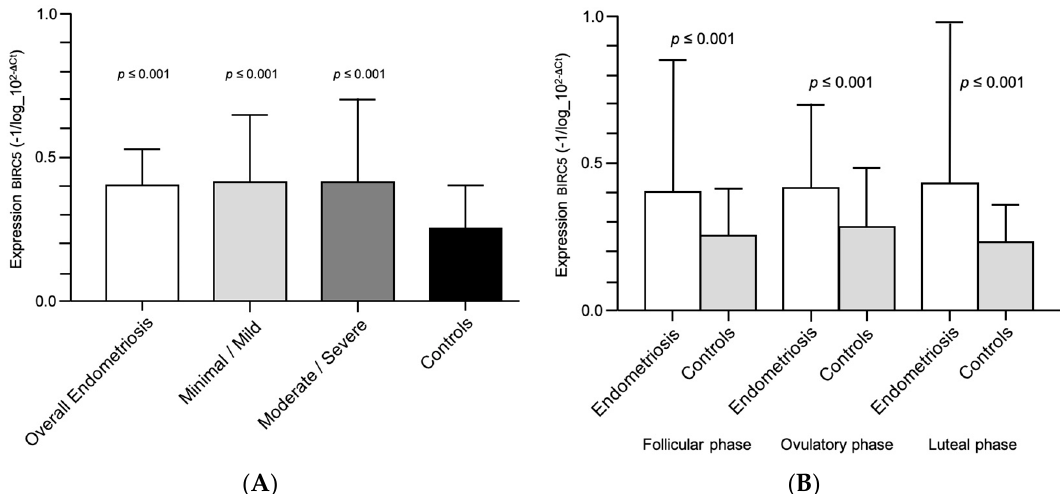
Figure 1. ( A ) BIRC5 expression in the peripheral blood samples of women with endometriosis according to the disease stage. ( B ) BIRC5 expression in the peripheral blood samples of women with and without endometriosis in different phases of the menstrual cycle. Table 2. Correlation between hormone levels and BICR5 expression in peripheral blood of women with endometriosis.